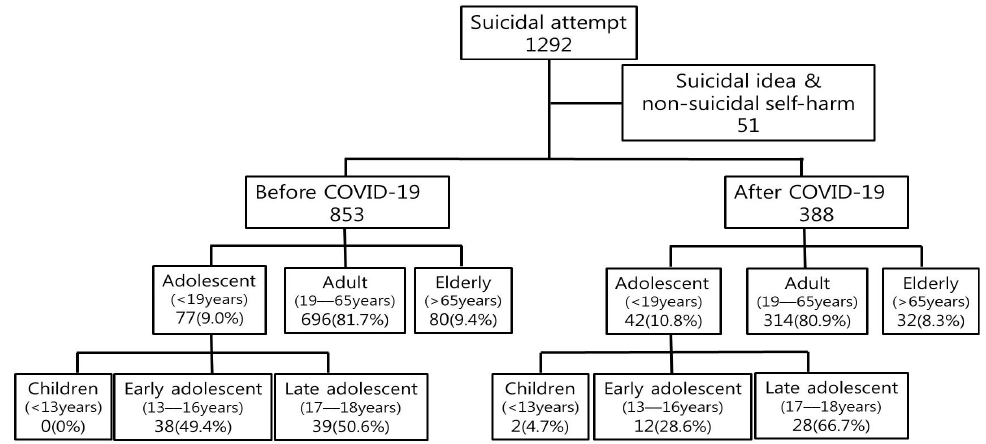
Figure 1. Patient flow chart. After applying the exclusion criteria, the data was divided into before and after COVID-19 and analyzed by